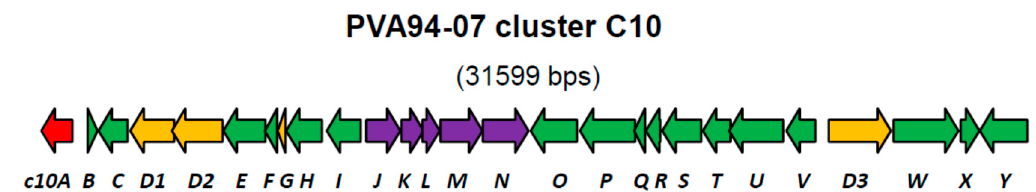
Figure 1. Organization of the C10 putative biosynthetic gene cluster in the genome of S. albus PVA94-07. Genes encoding NRPSD-related proteins are in yellow; a LysR-type encoding regulator is in red; and the genes encoding putative modification enzymes are in violet. Genes encoding enzymes with various catalytic activities known to be involved in secondary metabolite biosynthesis are shown in green. A detailed description of the predicted gene function is given in Table 1.